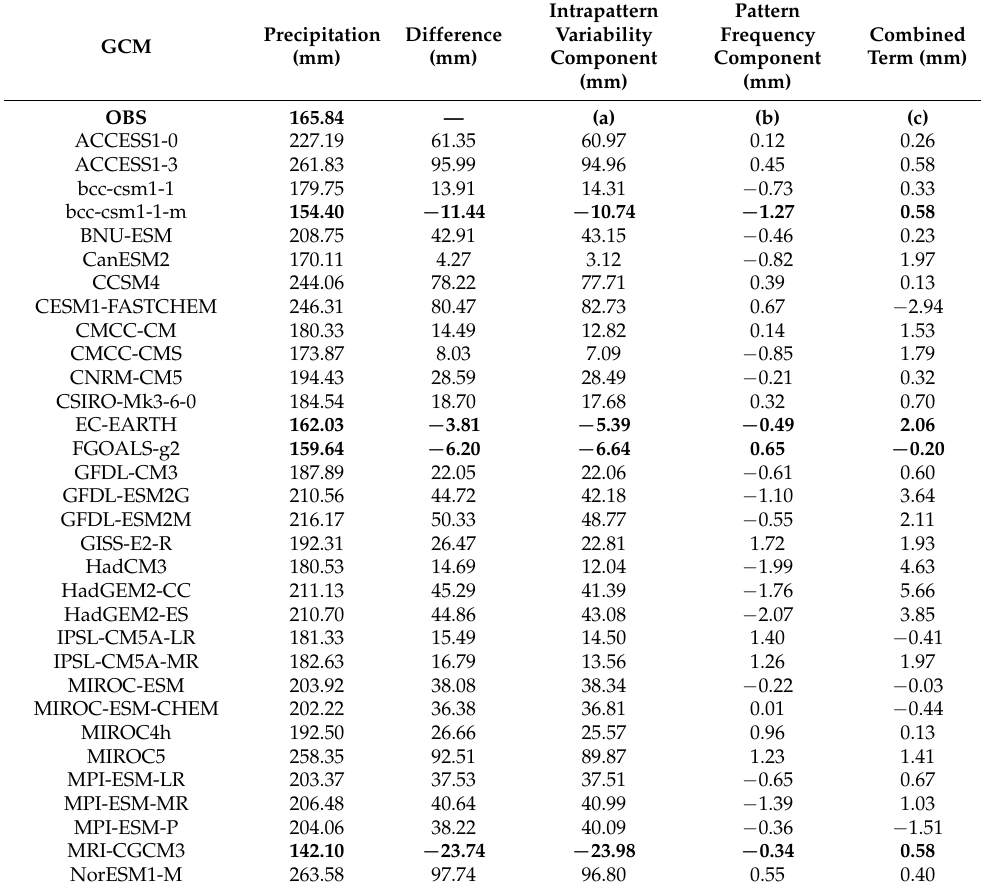
Table 5. Attribution of China’s precipitation difference between OBS and the individual GCMs in